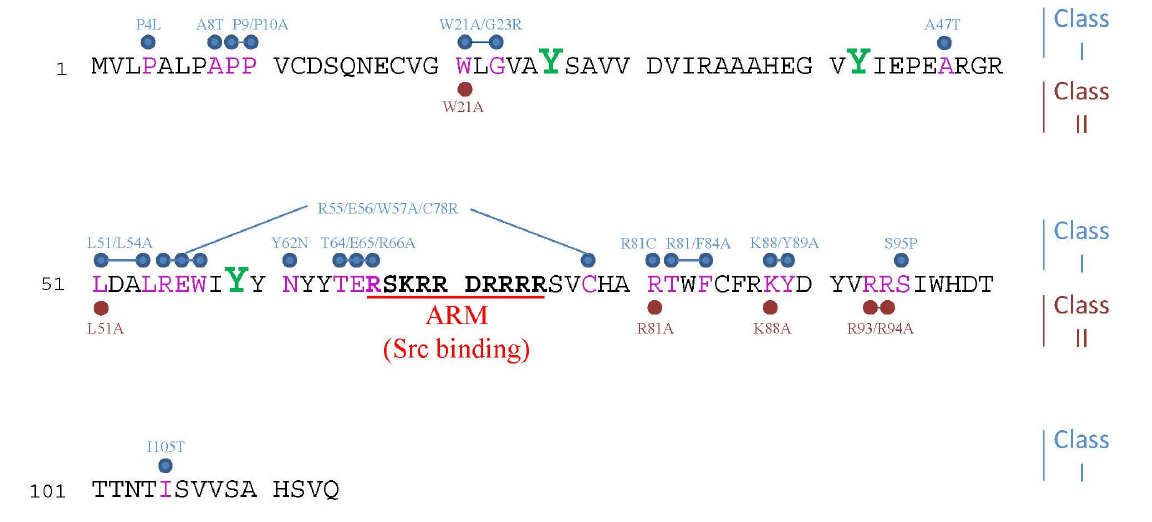
Figure 1. Mutation analysis of PP2A and Src binding sites in E4orf4. The Ad5 E4orf4 protein sequence is shown. The basic E4ARM domain is displayed in bold and underlined in red. The tyrosines that are phosphorylated by Src kinases are in bold green and a larger font. Other residues involved in E4orf4-induced cell death are marked in pink. Mutations in the E4orf4 sequence that reduced association of E4orf4 with a PP2A phosphatase activity by at least two-fold and impaired E4orf4-induced cell death (‘class I’ mutants [11]) are shown above the sequence in light blue. Mutations that did not reduce the E4orf4-PP2A interaction more than two-fold but were deficient in induction of cell death (‘class II mutants’) are shown below the sequence in dark red. Three more mutations were found to reduce PP2A binding: V19A/T102I, A25T/ Δ D52/R87C and Δ V29/R81C, which are not shown for simplicity sake. The basic E4orf4 ARM domain is required for Src kinase binding, but has only a low effect on PP2A binding